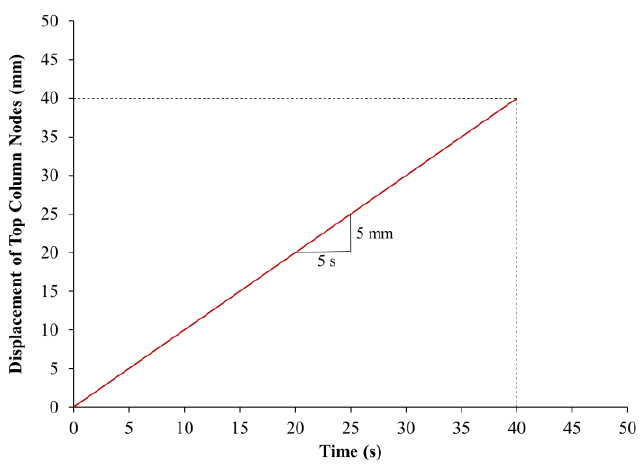
Figure 18. Prescribed axial displacement versus time curve used in the FE modeling.